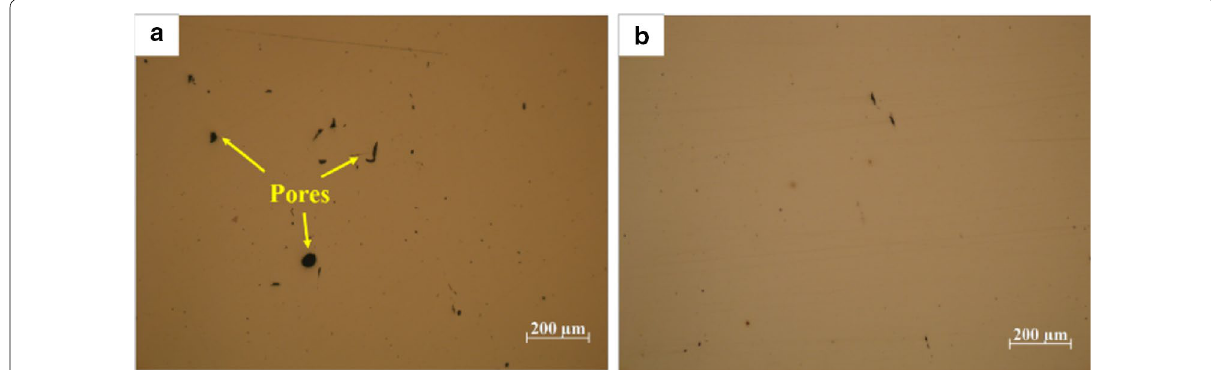
Figure 4 The OM images of polished cross section of a SLM‑processed sample; b casting